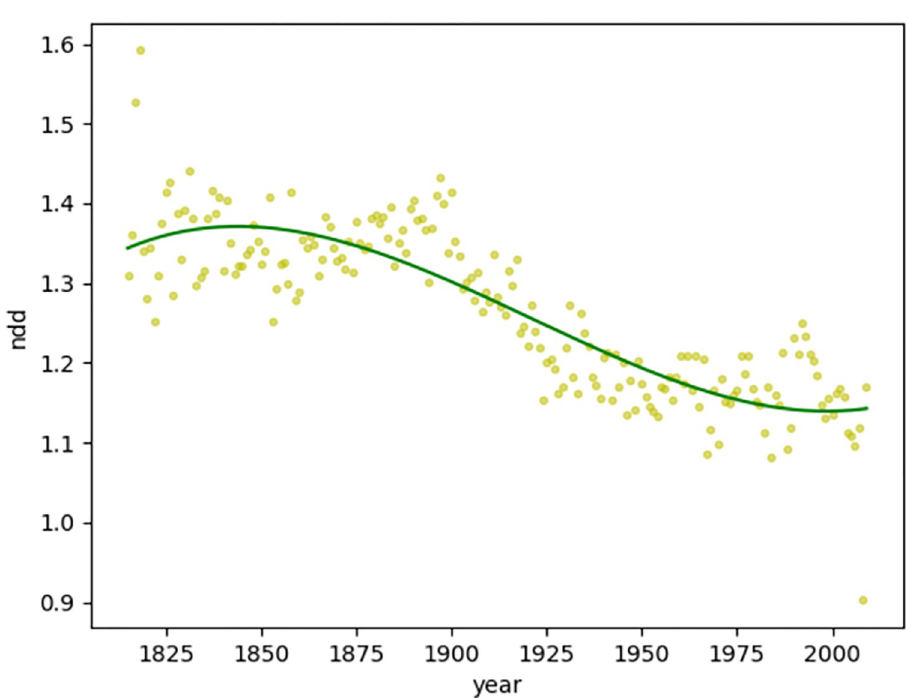
Fig 5. Diachronic non-linear distribution of NDD for magazine